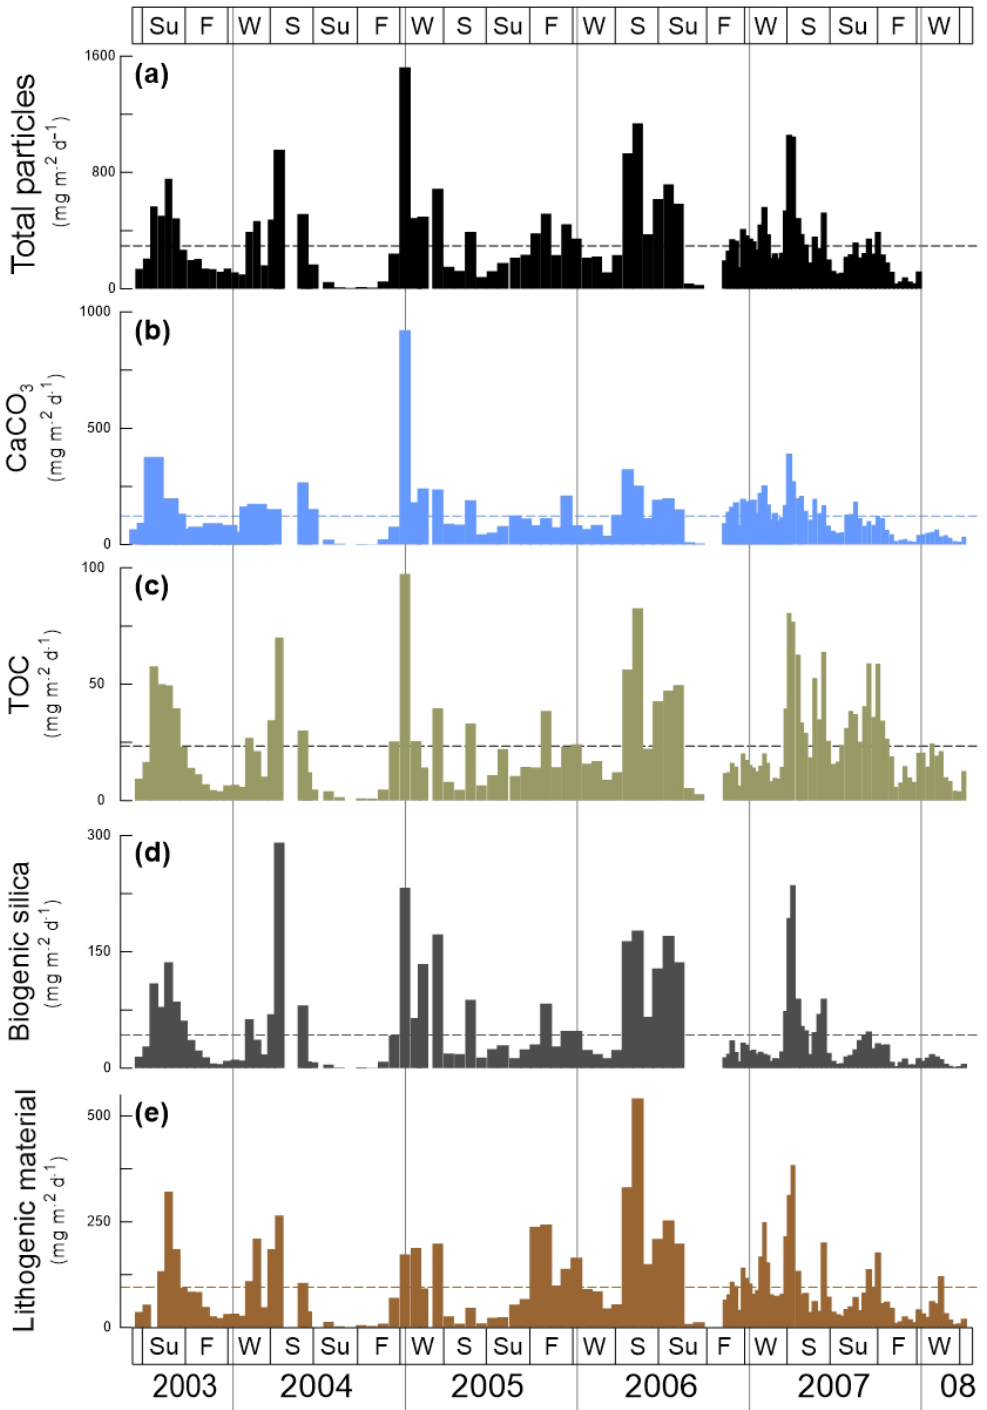
Figure 2. Total mass particle and bulk fluxes at the trap site CBeu between June 2003 and March 2008. From top to bottom: (a) total mass particle (mgm − 2 d − 1 , black bars), (b) calcium carbonate (CaCO 3 , mgm − 2 d − 1 , light blue bars), (c) total organic carbon (TOC, mgm − 2 d − 1 , olive bars), (d) biogenic silica (BSi, opal, mgm − 2 d − 1 , dark gray bars), and (e) lithogenic material (mgm − 2 d − 1 , brown bars). The horizontal stripped line for each parameter represents the average flux for the whole studied interval (Table 1). The boxes in the upper and lower panels represent seasons (Su: summer, F: fall, W: winter, S: spring). The vertical background gray lines indicate calendar year separation. For interpretation of the references to color in this figure legend, the reader is referred to the web version of this